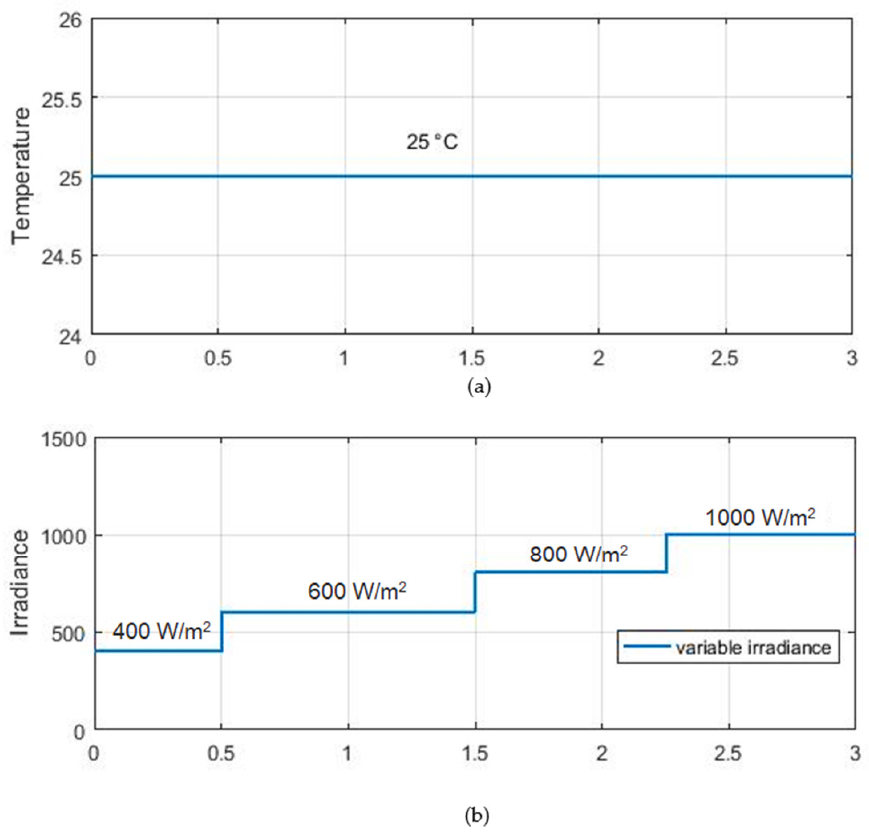
Figure 9. ( a ) Invariable temperature, it is set at 25 °C. ( b ) Ramp change of irradiance level.